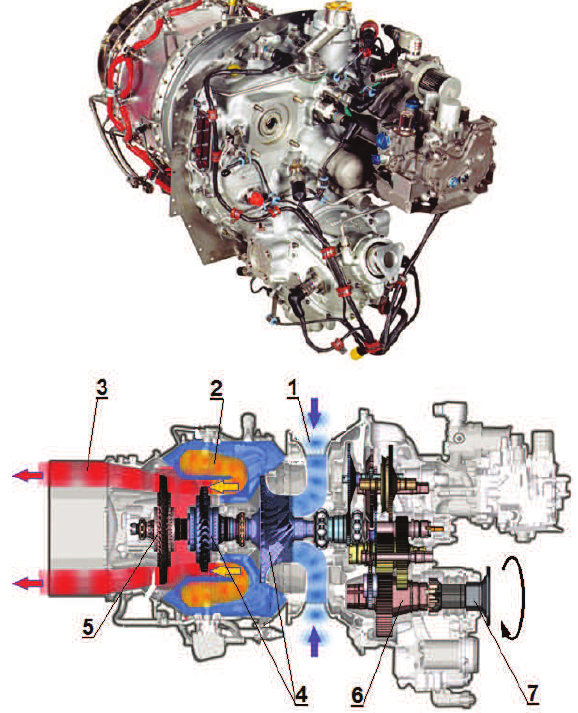
Fig. 17. View and cross-section of the PW 206 turboshaft engine: 1 – air inlet, 2 – combustor chamber, 2 – compressor, 3 – exhaust, 4 – radial com- pressor and turbine, 6 – reduction gearbox, 7 – shaft [17] Table 12. Model and number of the turboshaft powerplants Engine model